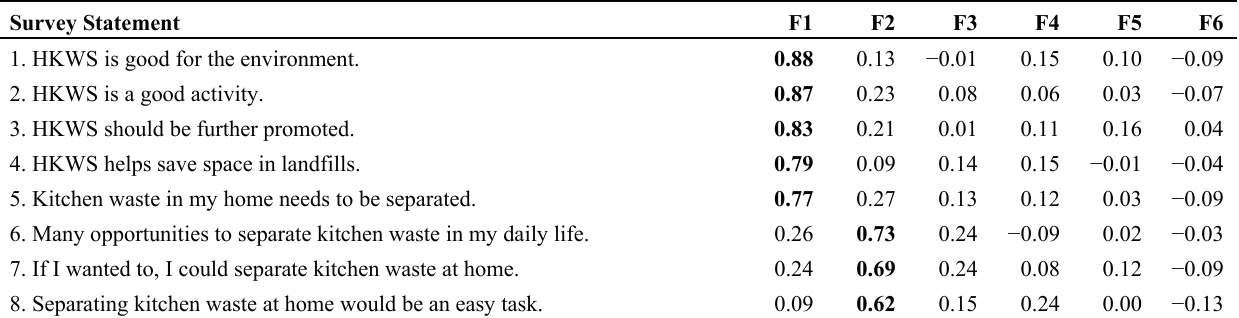
Table 5. Rotated component matrix of 28 five-level Likert scale statements (n =